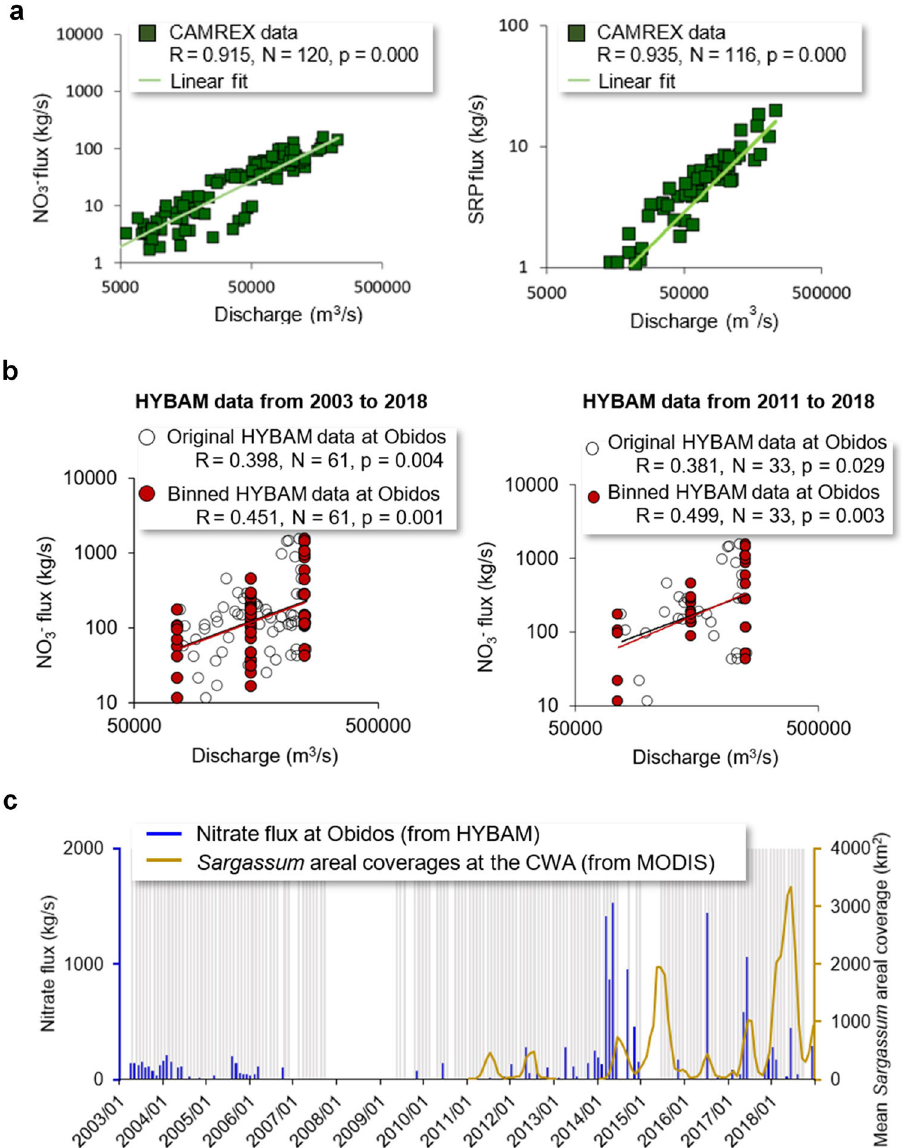
Fig. 5 Nutrient fl ux from the Amazon River and long-term Sargassum trend. a Nitrate (NO 3 − ) and soluble reactive phosphorus (SRP) fl ux from all stations of the 13 CAMREX cruises 83 (1982 to 1991) are highly correlated with river discharge. These stations are within a 2000 km reach of the Brazilian Amazon River mainstream. Solid lines mark the power law regression lines. b NO 3 − fl ux at Obidos from the HYBAM database 100 is also correlated with discharge, and the correlation is higher if data are binned to different discharge groups. c NO 3 − fl ux at Obidos from the same HYBAM dataset shows apparent increases in recent years. The recent mean monthly Sargassum areal coverages obtained from Wang et al. (2019) in the Central West Atlantic (CWA, 0 o N to 22 o N, 63 o W to 38 o W) are also shown as reference. All months before 2011 show Sargassum coverages. The shaded gray bars indicate when quality controlled HYBAM nutrient fl ux measurements are available, but data in some months are too low (<0.1 mg/L) to be visible due to the